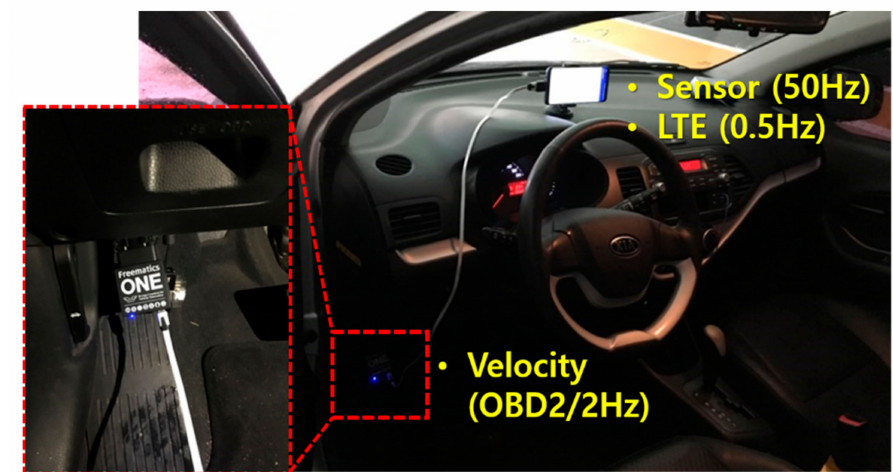
Figure 4. Experimental setting.